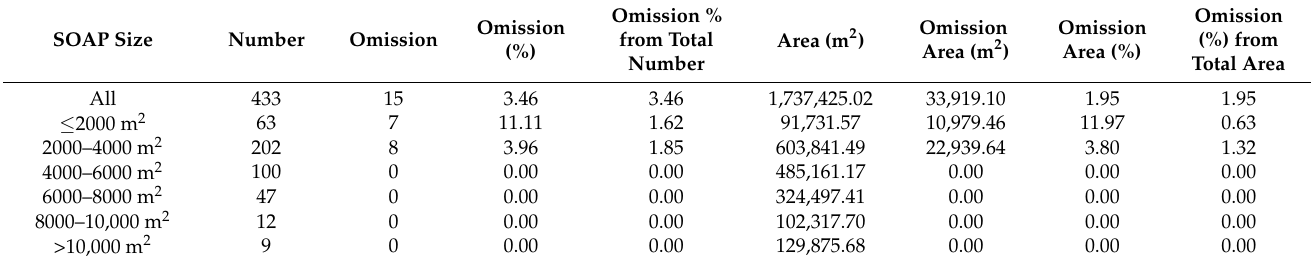
Table 2. Omission error evaluation from the comparison between labeled and extracted SOAPs. The statistics show the number of SOAPs (and their areas) that the proposed method did not extract for different SOAP size classes.